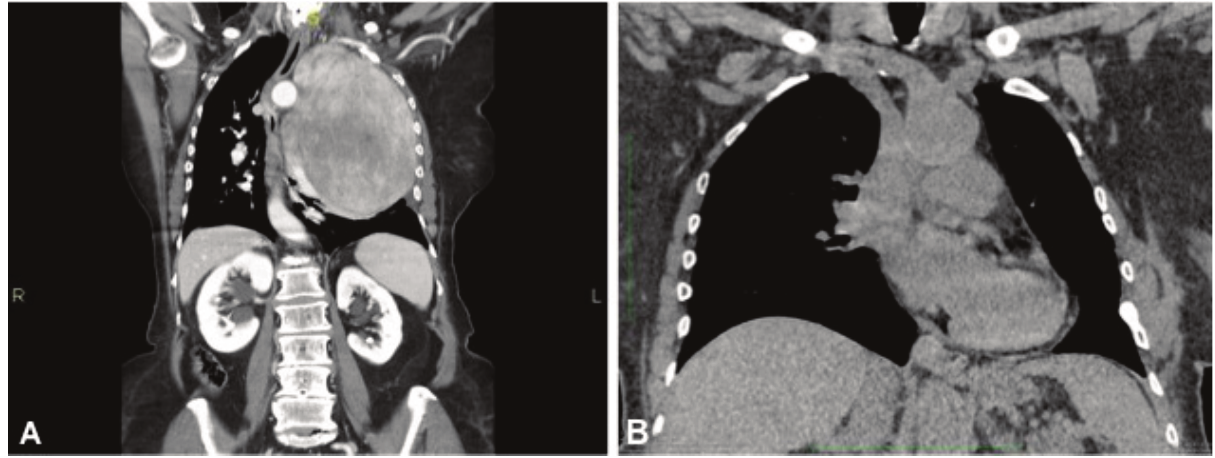
Figure 1: Giant solitary fibrous tumor of the pleura CT-scan (coronal view): pre-surgical assessment (A); post-surgical view